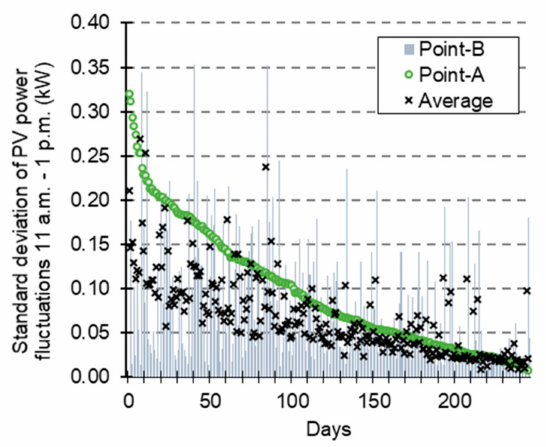
Figure 3. Daily standard deviation of PV power fluctuations (11:00 a.m.–1:00 p.m.).